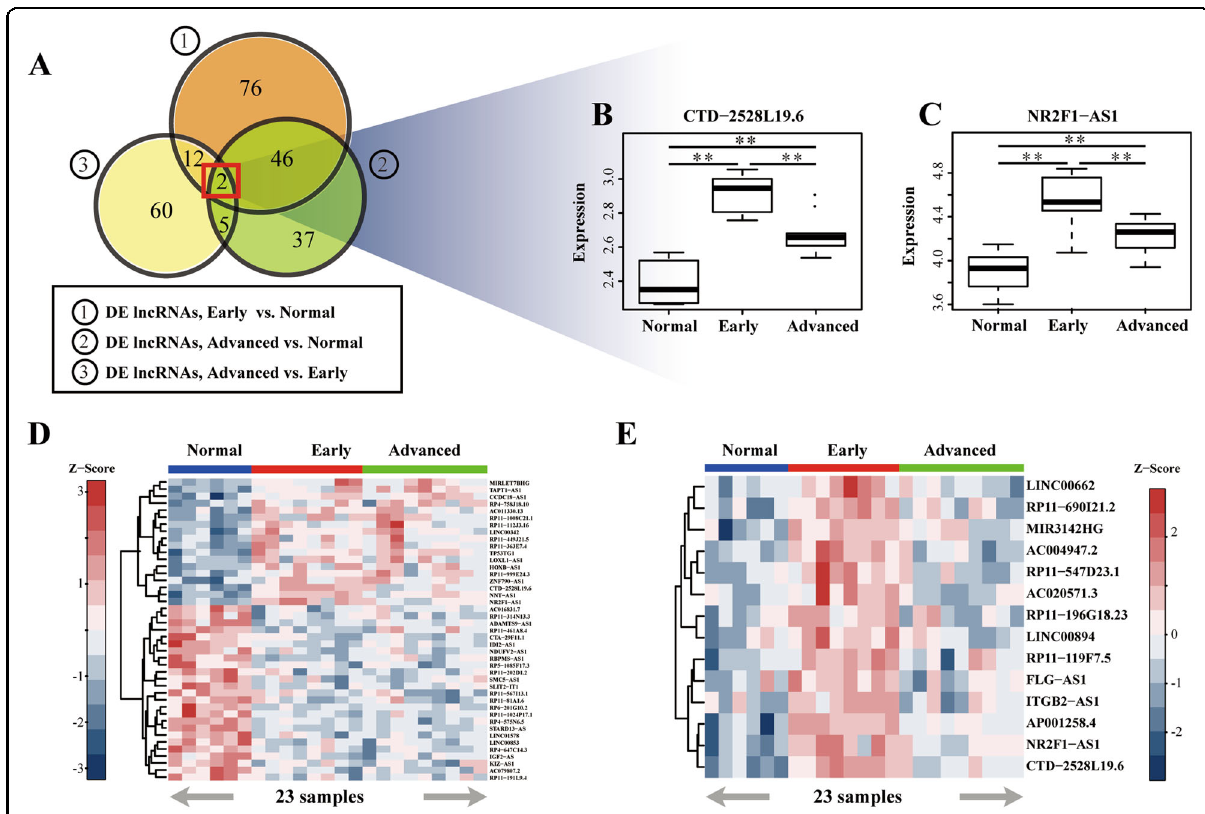
Fig. 1 Identi fi cation of IPF lncRNAs signatures. A Venn diagram of overlapping DE lncRNAs among three groups. B , C Distribution of expression levels for key lncRNAs CTD - 2528L19 .6 and NR2F1-AS1 . * P < 0.05, ** P < 0.01 in Student ’ s t -test. D , E Heatmaps show the global expression levels of IPF pathogenic lncRNAs ( D ) and IPF progression lncRNAs ( E ) in